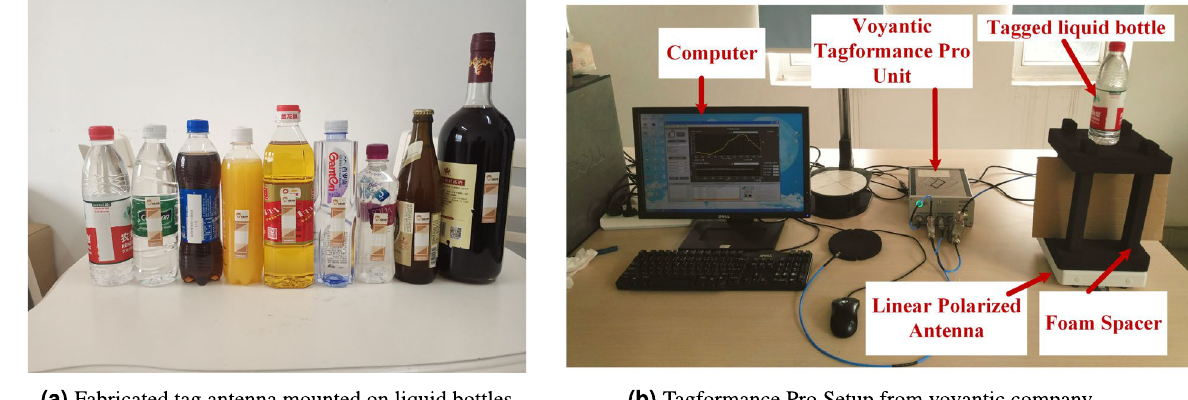
Figure 13. Measurement set for read range of proposed tag after mounting on different liquid